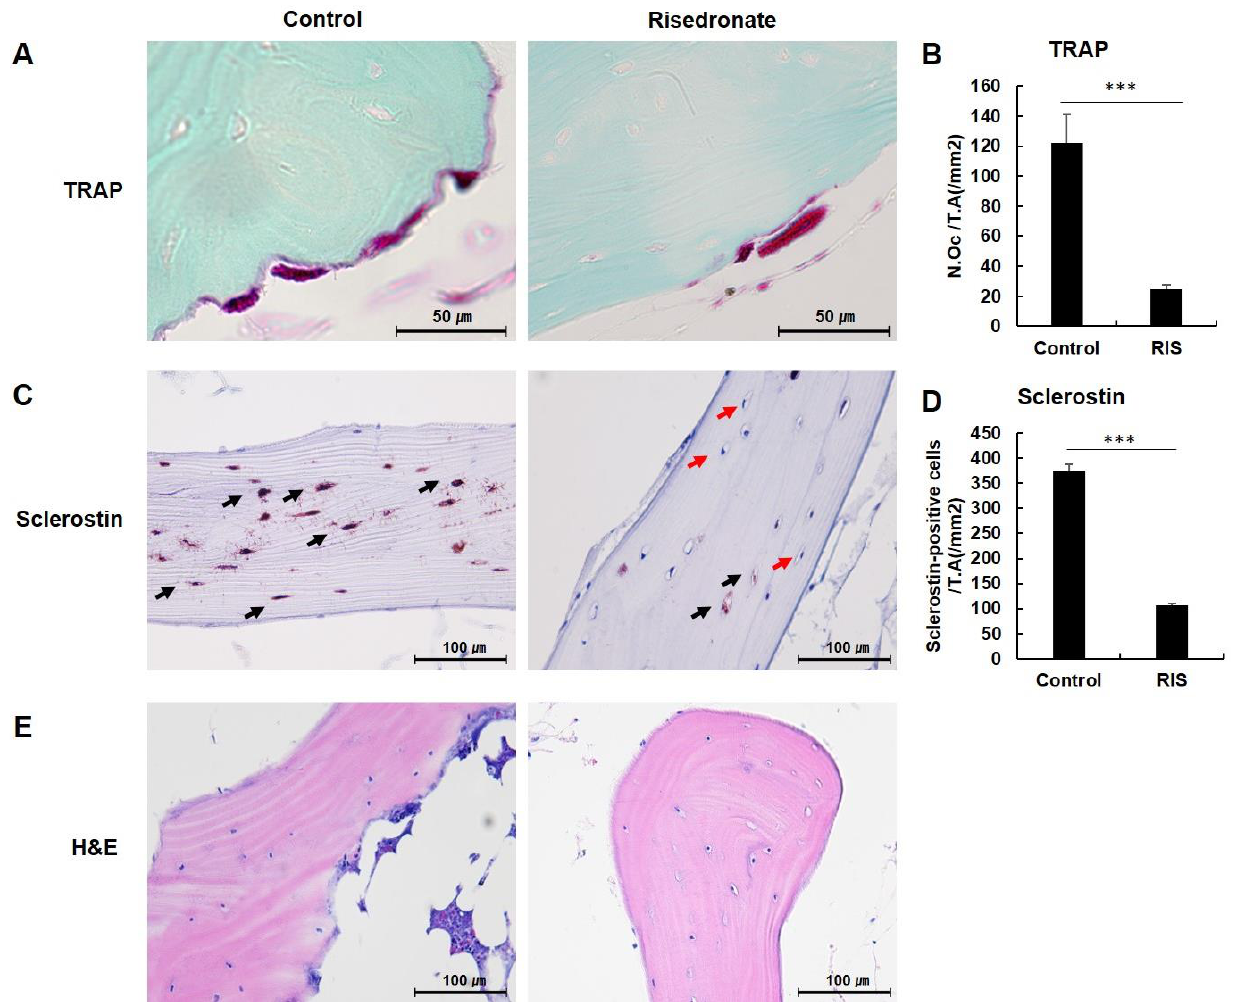
Figure 2. ( A ) Histology of tartrate-resistant acid phosphatase (TRAP) staining of the femoral head. ( B ) Quantitative analysis of the number of osteoclasts. ( C ) Sclerostin immunohistochemistry of the femoral head. Osteocytes show labeling for sclerostin (black arrow), and some osteocytes do not show staining of sclerostin (red arrow). ( D ) Quantitative analysis of the number of sclerostin-positive osteocytes. ( E ) Histology of hematoxylin and eosin (H&E) staining (*** p < 0.005).